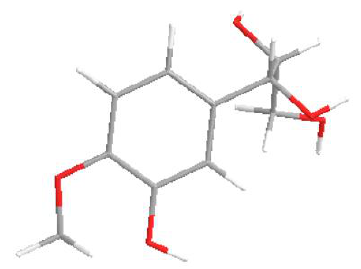
Figure 2. Key NOESY correlation of compound 1 .